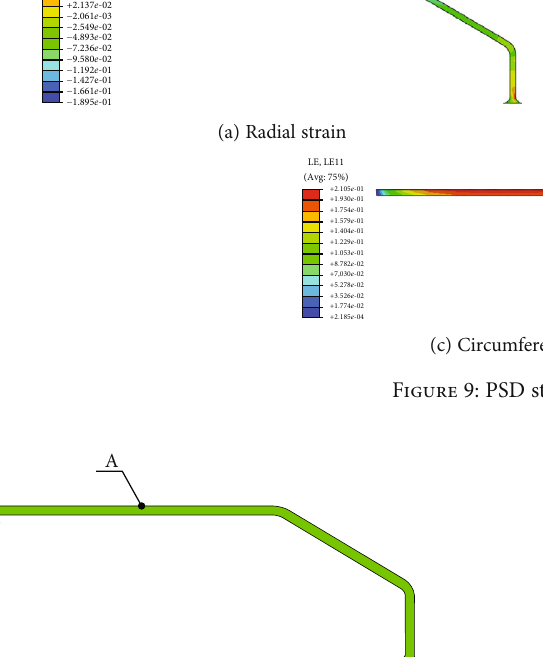
Figure 10: The maximum strain point of the soft PSD (point